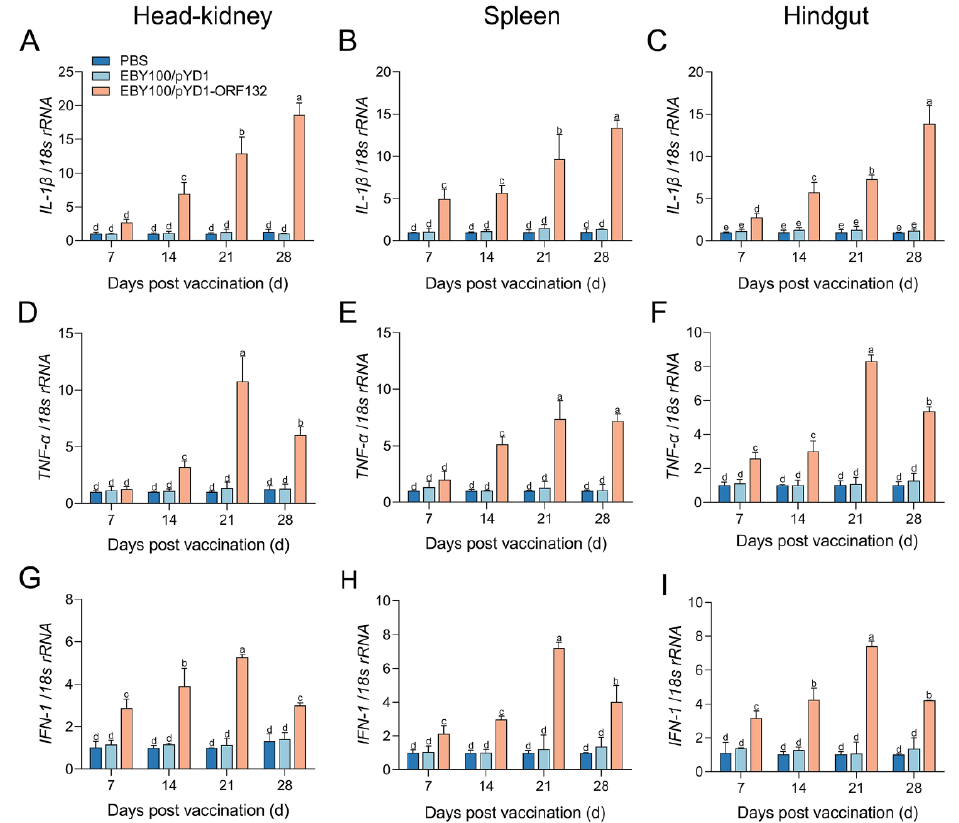
Figure 4. mRNA expression levels of IFN-1 , TNF- α , and IL-1 β in the head–kidney ( A , D , G ), spleen ( B , E , H ), and hindgut ( C , F , I ) after the oral vaccination. Bars with different letters were significantly different according to Duncan’s multiple range ( p < 0.05).